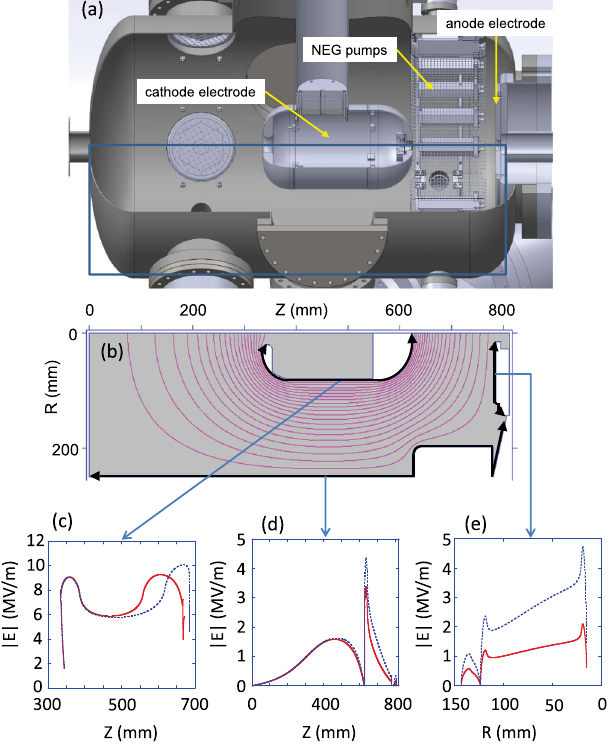
FIG. 9. (a) Cutaway drawing of gun chamber configuration (C) with 160-mm acceleration gap and (b) radial cross section showing calculated static electric field for gun chamber. Surface electric field distributions (red solid lines) (c) of the cathode as a function of Z and of the anode as a function of (d) Z and (e) R at 500 kV. Blue dashed lines show corresponding field distributions with 100-mm gap from Fig.